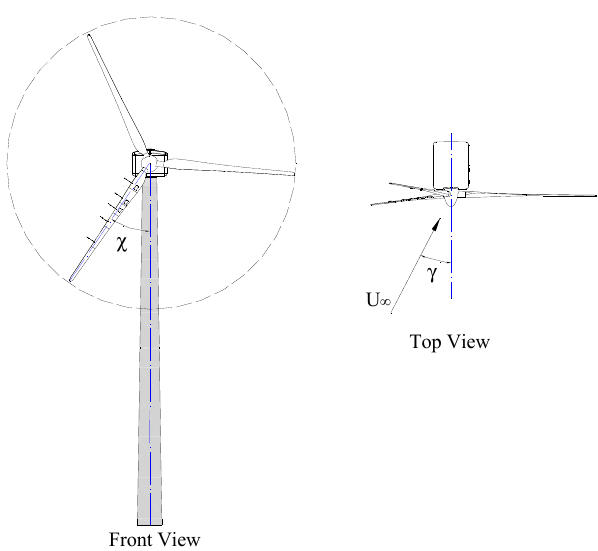
Figure 12. Definitions of azimuth angle of rotor and yaw angle of wind turbine.